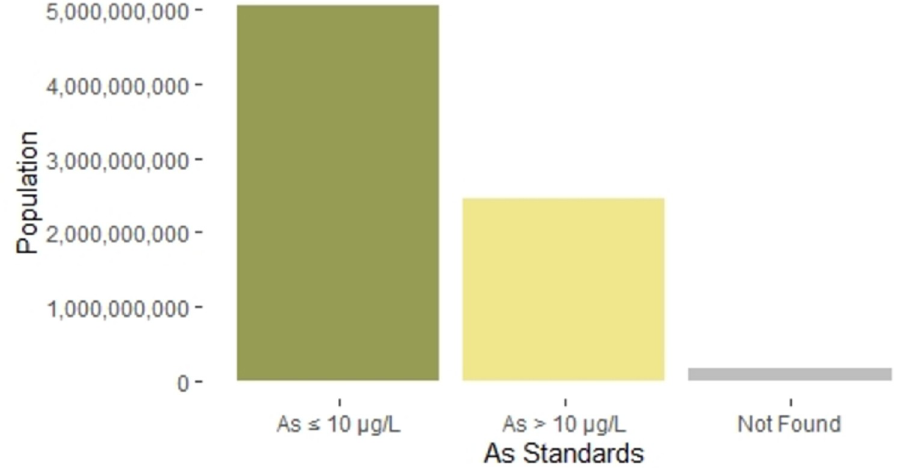
Fig 2. Comparison of populations covered by different levels of arsenic drinking water